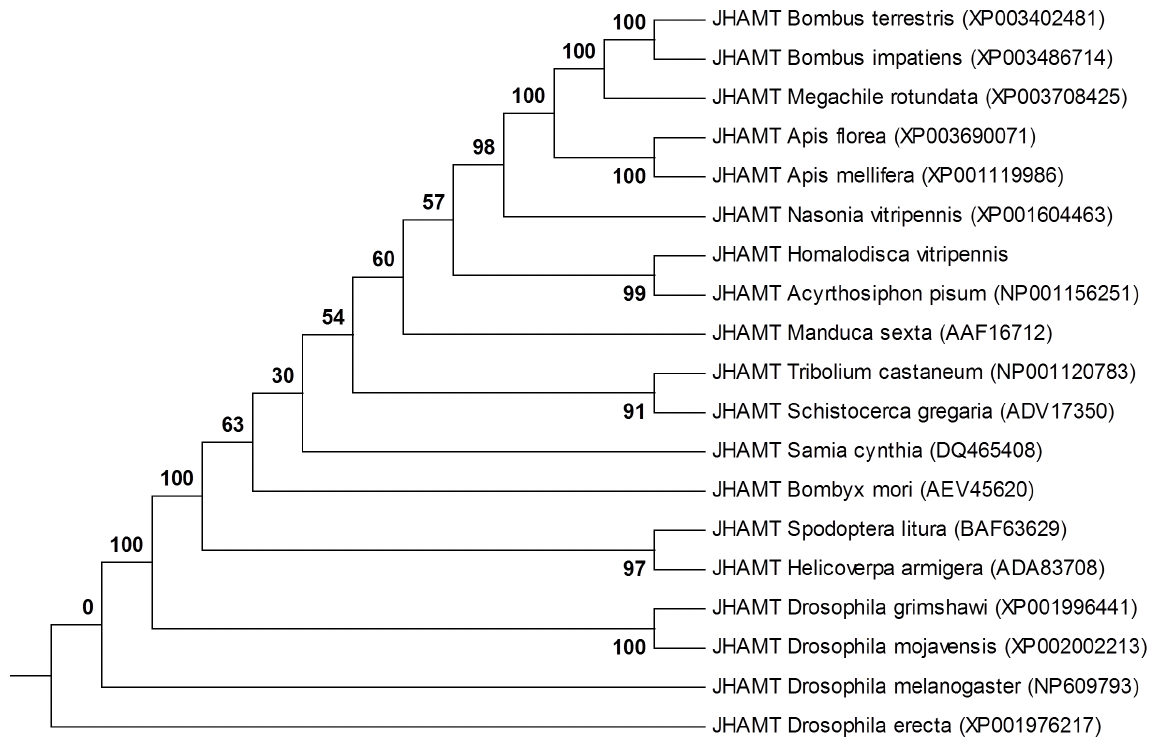
Figure 7. Phylogenic comparisons of juvenile hormone acid methyl transferase protein sequences of H.vitripennis and those other insect orders. The evolutionary relatedness of juvenile hormone acid methyl transferase (JHAMT) of H . vitripennis with other insect JHAMT proteins is shown. The evolutionary history was inferred using the Neighbor-Joining method. The bootstrap consensus tree inferred from 500 replicates is taken to represent the evolutionary history of the taxa analyzed. The right panel in the figure shows the RT-PCR gel picture validating the JHAMT transcript from H. vitripennis insects.